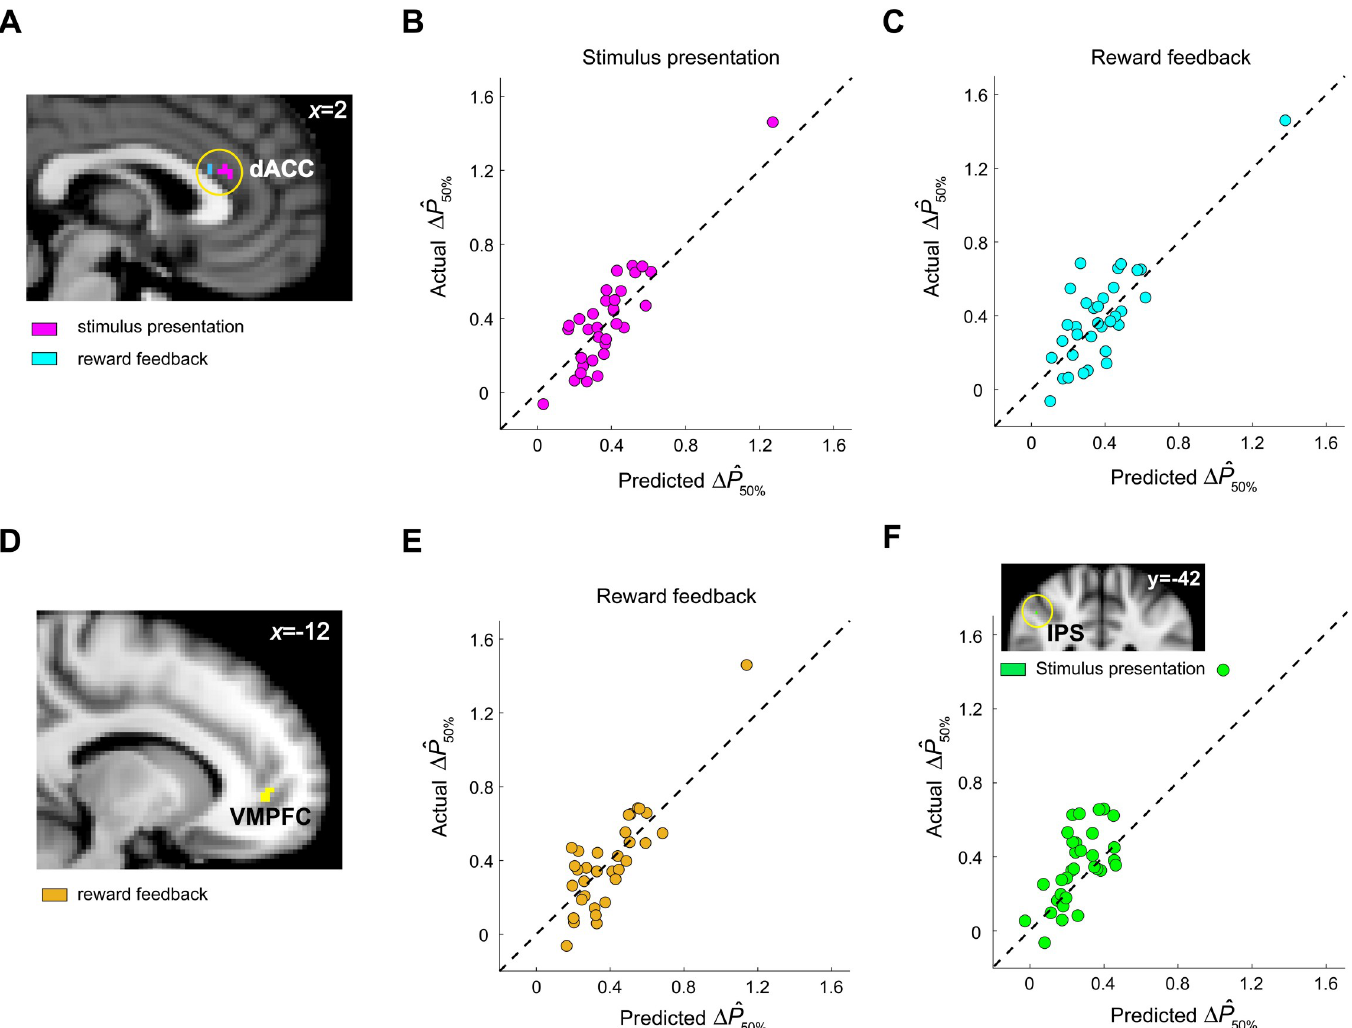
Fig 9. dACC, VMPFC, and rIPS represent context effect on probability estimates. (A–C) dACC results. (A) In a between-subject, cross-validated MVPA, we found that Þ using activity patterns at the time of stimulus patterns of multivoxel activity in dACC predicted context effect on individual subjects’ probability estimates ð D ^ P 50% presentation (magenta) and at reward feedback (cyan; p < 0.05, Bonferroni corrected for 1,350 voxels in the dACC ROI). The voxels shown are the ones that survived Bonferroni correction. (B) Actual D ^ P plotted against predicted D ^ P based on activity pattern—at the time of stimulus presentation—in the searchlight centered on 50% 50% (referred to as the peak voxel). (C) Actual D ^ P plotted against predicted D ^ P the dACC voxel that produced the largest correlation between actual and predicted D ^ P 50% 50% 50% based on activity pattern—at the time of reward feedback—of the peak voxel in dACC. (D–E) VMPFC results. (D) VMPFC voxels that significantly predicted behavioral context effect ð D ^ P Þ at the time of reward feedback ( p < 0.05, Bonferroni corrected for 1,776 voxels in the VMPFC ROI). The voxels shown are the ones that survived 50% Bonferroni correction. (E) Scatter plot using data from the peak VMPFC voxel. Conventions are the same as in panels B and C. (F) rIPS results ( p < 0.05, Bonferroni corrected for 196 voxels in the rIPS ROI). Scatter plot using data from the peak rIPS voxel. The dashed line in panels B, C, E, and F represents the 45-degree line, indicating perfect prediction. Data underlying these graphs can be found in https://osf.io/48j7m. dACC, dorsal anterior cingulate cortex; MVPA, multivoxel pattern analysis; rIPS, right intraparietal sulcus; ROI, region of interest; VMPFC, ventromedial prefrontal cortex.